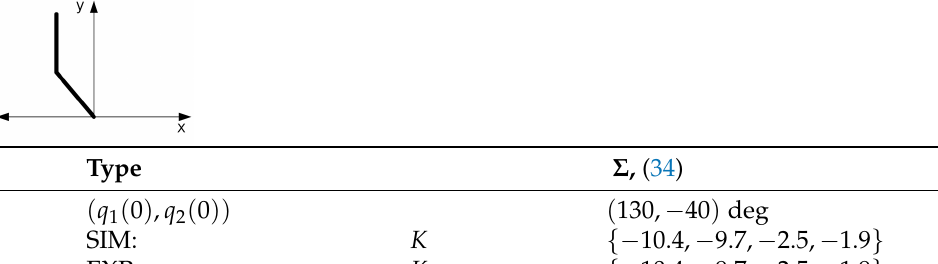
Table 7. Case A2: Initial posture of the Pendubot and parameters of the linear controller.